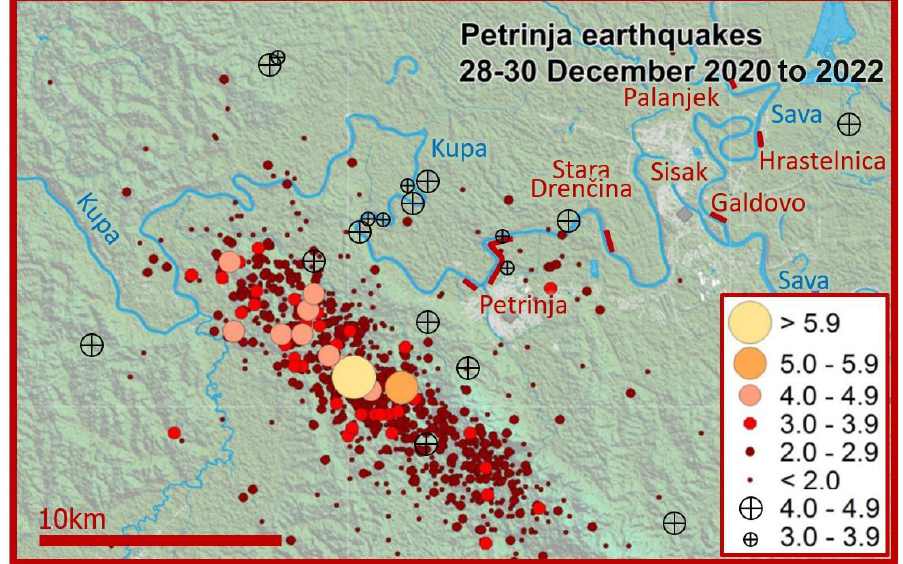
Figure 4. Epicentres of the 2020 Petrinja earthquake, its foreshocks and aftershocks from 28 December to 30 December 2020 — shown with coloured circles (Croatian Seismological Survey, 2020) [14] and epicentres of earthquakes of magnitude 3 or stronger from 31 December 2020 to 29 December 2022 — shown in black symbols [5]. Locations of the damaged embankments are shown in red.